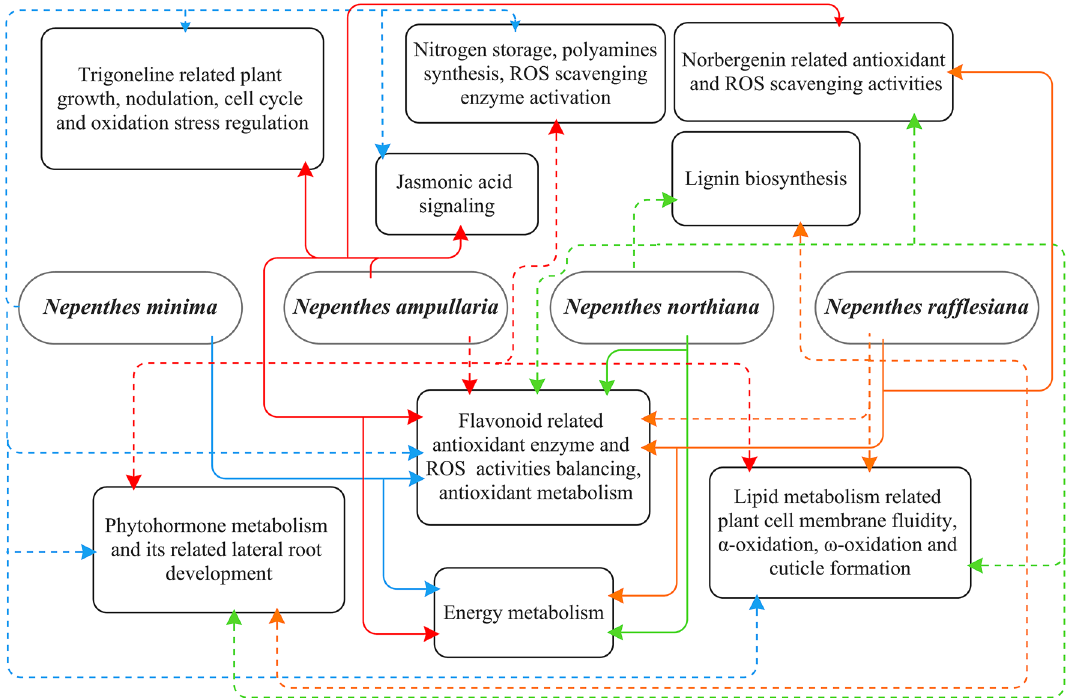
Figure 5. Adapting strategies applied by all 4 Nepenthes species in response to different environmental conditions. dot lines: strategies that used under highland cold stress exposure; solid lines: strategies that used under lowland heat stress